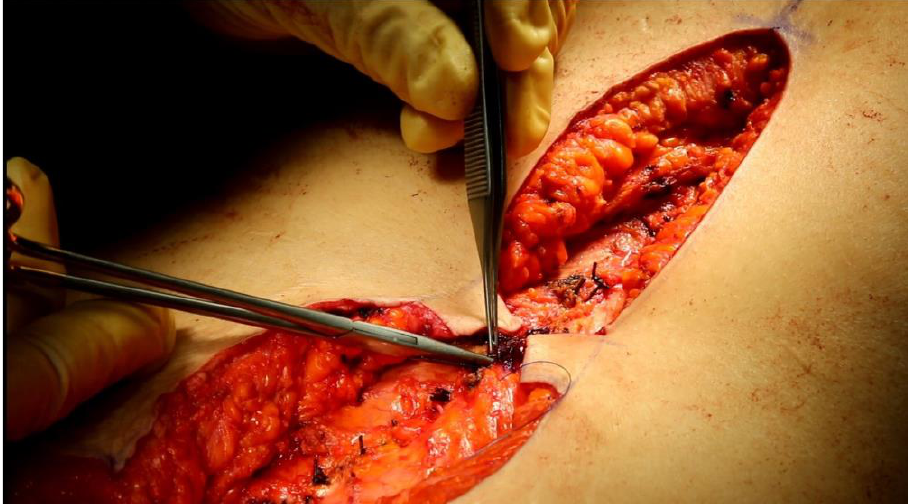
Figure 2. Two rectangular flaps are sutured on the muscular fascial layer.